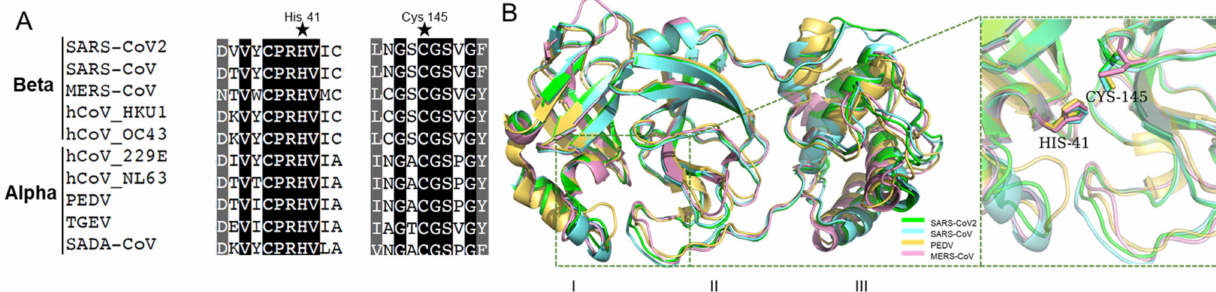
Figure 1. The conserved amino acid sequences and 3D structures of the M pro catalytic domains for different coronaviruses. ( A ) Alignment of neighbor residues on both flanks of the pivotal residue His41, Cys145. ( B ) The three-dimensional (3D) structures of M pro are highly